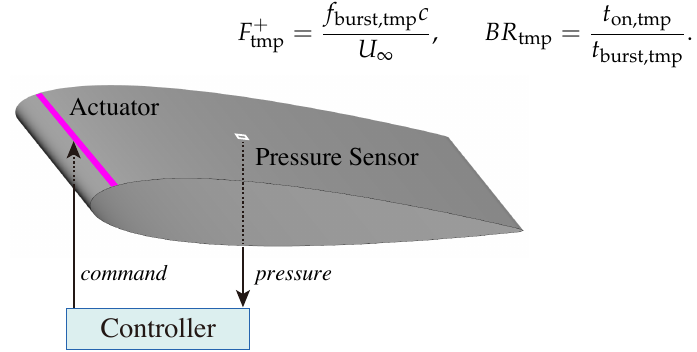
Figure 3. Schematic of the dynamic burst actuation.